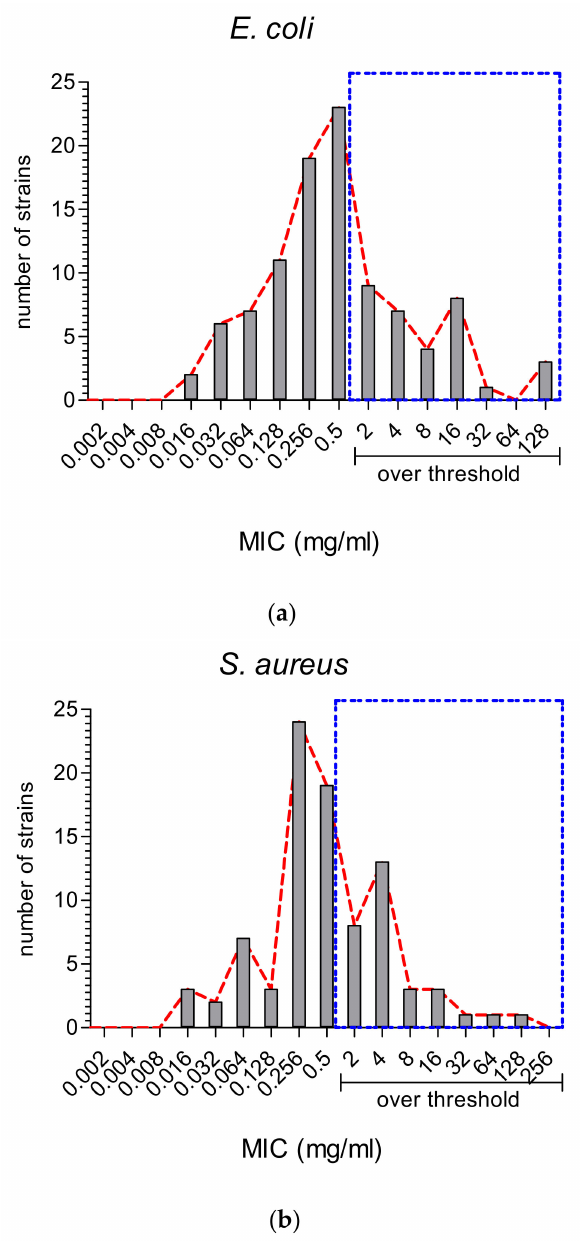
Figure 5. MIC values (in mg/mL) reported in the thirty-eight studies for MWEPs extracts vs. the two main and most studied pathogenic bacteria: ( a ) the Gram-negative E. coli and ( b ) the Gram-positive S. aureus